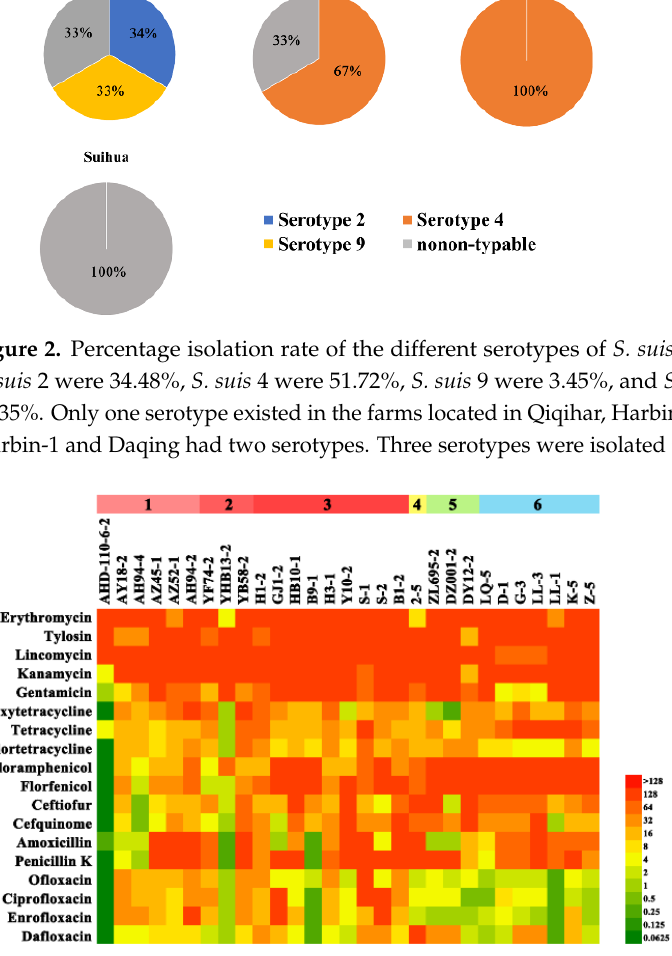
Figure 2. Percentage isolation rate of the different serotypes of S. suis isolated from the six farms. S. suis 2 were 34.48%, S. suis 4 were 51.72%, S. suis 9 were 3.45%, and S. suis with no serotype were 10.35%. Only one serotype existed in the farms located in Qiqihar, Harbin-3, and Suihua. The farms in Harbin-1 and Daqing had two serotypes. Three serotypes were isolated the farm located in Har- bin-2.